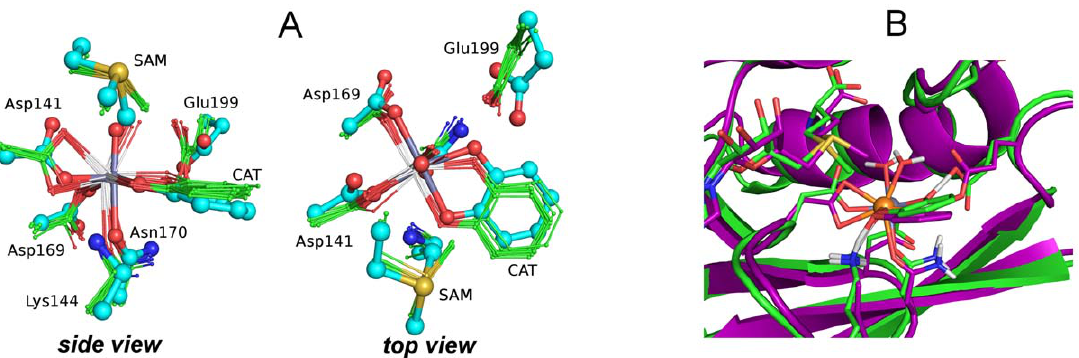
Figure 4. Comparison between Mg(II) and Ca(II) forms of COMT. A) Simulated active site for the Ca based COMT (thin sticks, small spheres) and the active site derived from the X-ray structure of Mg-COMT (bold sticks, large spheres). Hydrogen atoms, Met40, Lys46 and Asp205 have been omitted for clarity. B) The overlay of the representative snapshots from the QM/DMD simulations on Mg(II)-COMT (green structure, gray metal) and Ca(II)-COMT (purple structure, orange metal), showing the overall structural adjustment in